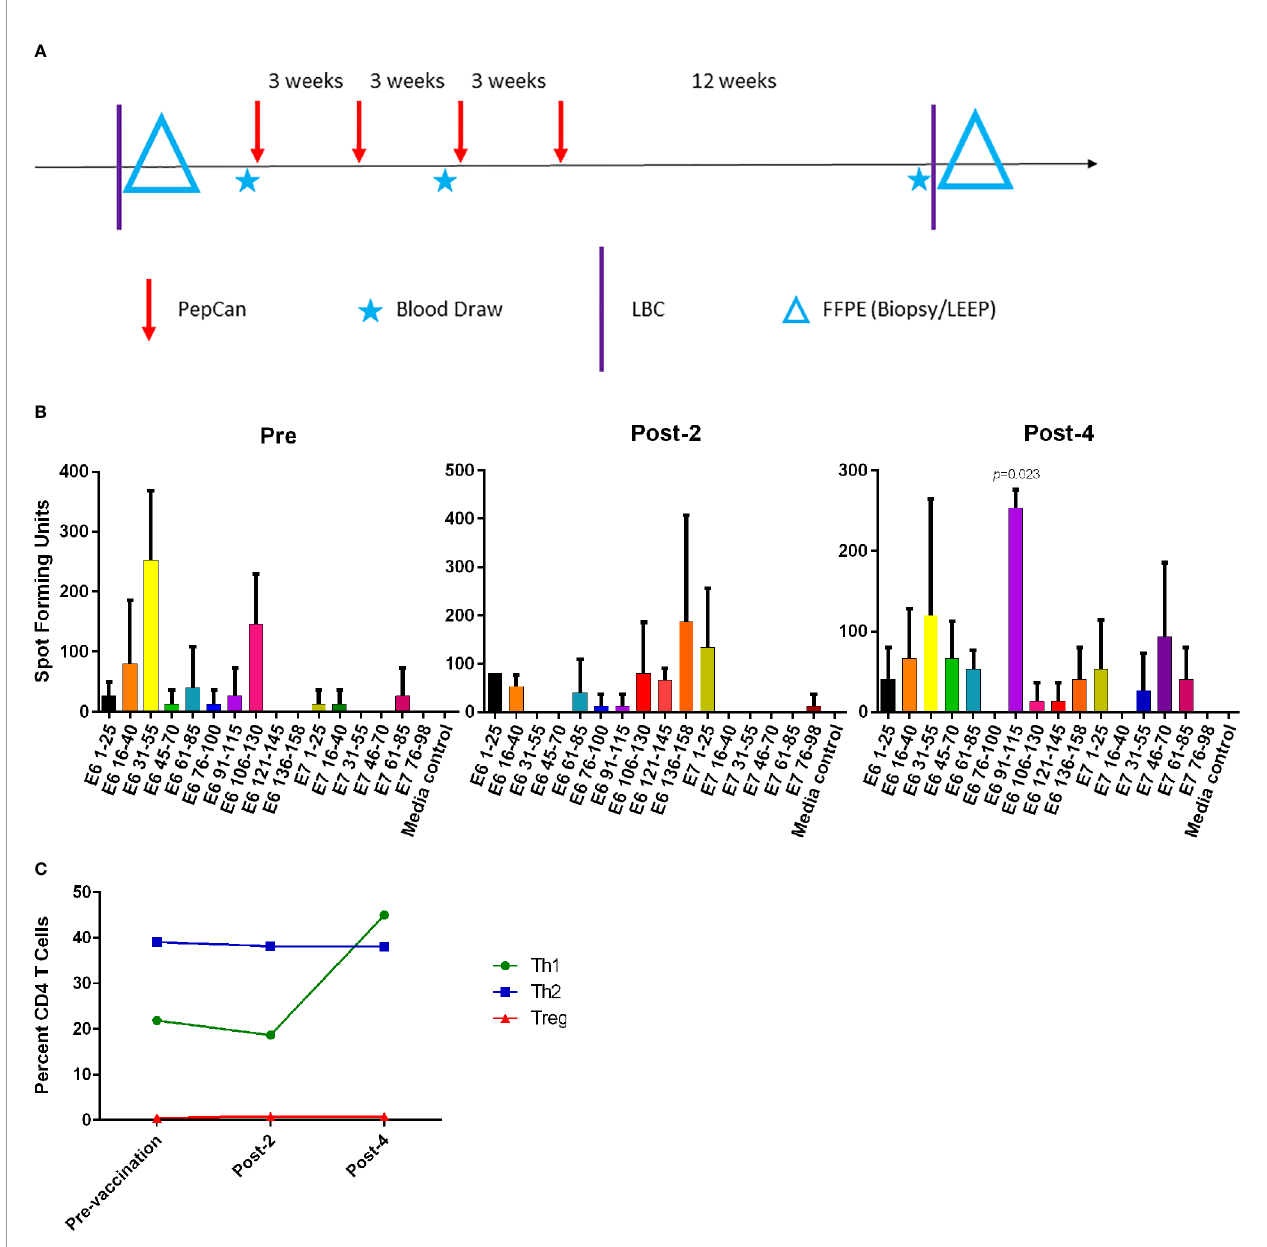
FIGURE 1 | The Phase I clinical trial design and routine immune monitoring assays. (A) Clinical trial design of the Phase I study. Vaccination (PepCan) visits were scheduled 3 weeks apart for patients who had biopsy-con fi rmed cervical high-grade squamous intraepithelial lesions (HSILs, i.e. CIN grade 2 or 3). Blood draws were performed pre-vaccination, and post-2 and post-4 vaccinations. Cervical local samples (LBC and FFPE) were collected pre-vaccination and post-4 vaccinations. FFPE samples were prepared from a pre-vaccination cervical biopsy and from loop electrical excision procedure (LEEP) biopsy post-4 vaccinations. (B) Immunogenic HPV16 E6 and E7 regions were determined for each vaccine phase using IFN- g ELISPOT assay. In pre-vaccine phase, positive responses (i.e., at least twice the media control) were detected in the E6 16-40, E6 31-55, and E6 106-130 regions. Positive responses were seen in the E6 1-25, E6 106-130, E6 136-158, and E7 1-25 regions in the post-2 vaccination sample, and in the E6 31-55, E6 91-115, and E7 46-70 regions in the post-4 vaccination sample. The increase in the response to the HPV16 E6 91-115 regions was statistically signi fi cant (paired t -test, p =0.023) after 4 vaccinations. Phytohemagglutinin was used as a positive control (not shown). The y-axis represents mean spot forming units of triplicates per 1 x 10 6 CD3+ T cells, and error bars represent standard error of means. (C) The fl uorescent cell sorter analysis of PBMCs revealed that the Th1 (CD4+Tbet+) level expressed as the percentage of CD4+ T cells increased after 4 vaccinations, but Treg (CD4+CD25+FoxP3+) and Th2 (CD4+GATA3) levels were minimally